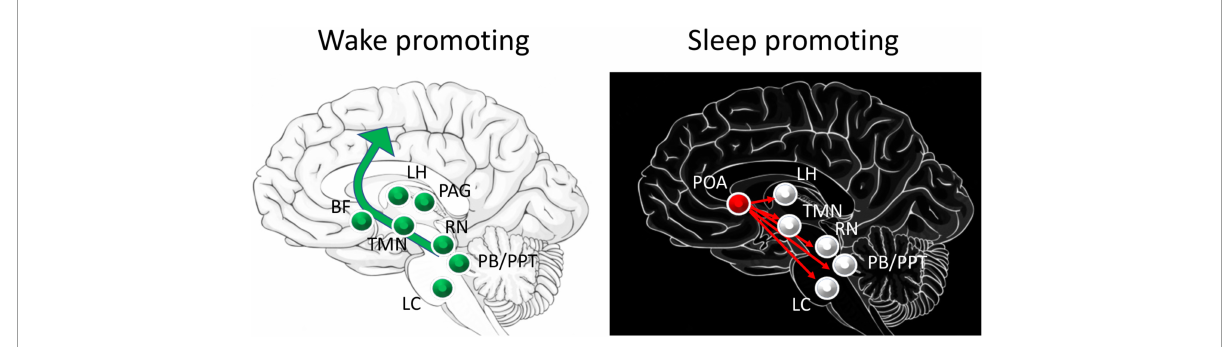
FIGURE1 Schematic of major circuits involved in sleep and waking. Major direct contributors to arousal and waking are the excitatory projections from the pedunculopontine tegmental nucleus (PPT) and the parabrachial nucleus (PB) to basal forebrain (BF) that projects broadly throughout the cortex, including the olfactory cortex. Neurons in the lateral hypothalamus (LH) contribute to inhibition of sleep promoting regions. Dopamine release by the periaqueductal grey (PAG) area directly contributes to waking, while histamine from the tuberomammillary nucleus (TMN), serotonin from the raphe nucleus (RN) and norepinephrine from the locus coeruleus (LC) have more modulatory roles in promoting cortical arousal. Sleep promoting regions include the preoptic area (POA), specifically the ventrolateral preoptic (VLPO) and median preoptic (MnPO) areas which send GABAergic projections to major components of the waking